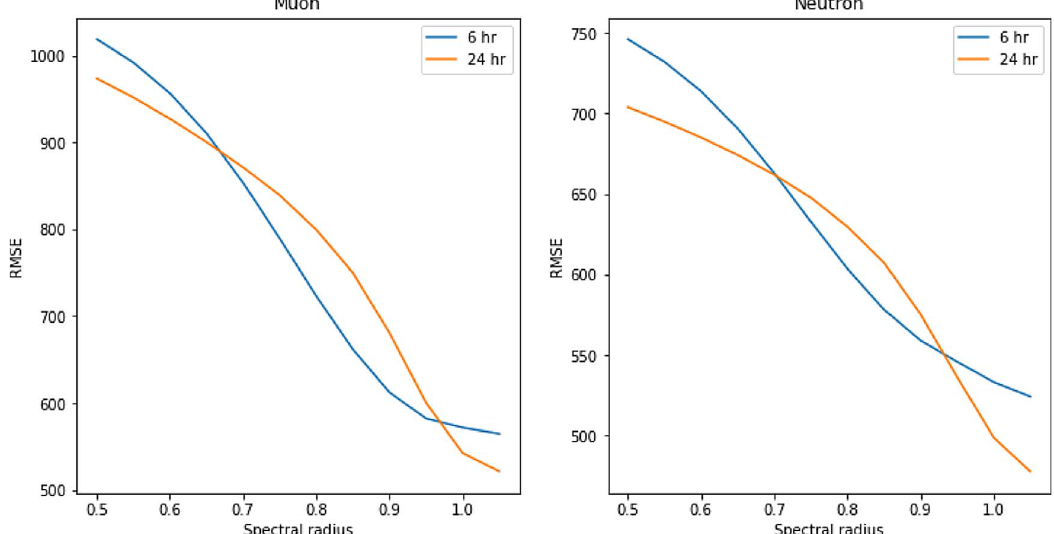
Figure B1. Root mean square errors between observed and modeled muon count rate (left) and neutron count rate (right), changing the spectral radius of the Echo State Network. We set the number of nodes to be 10 3 . Selected temporal resolutions are 6 h ( N = 6080) and 24 h ( N =